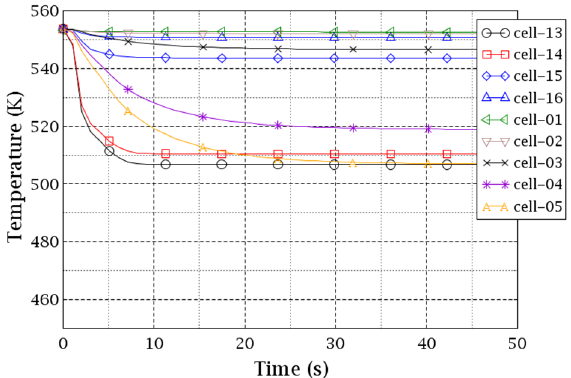
Figure 22. Evolution of the coolant temperature distribution at the core inlet of the AP1000 reactor CA-V hot-part (cell index is from Figure 21).